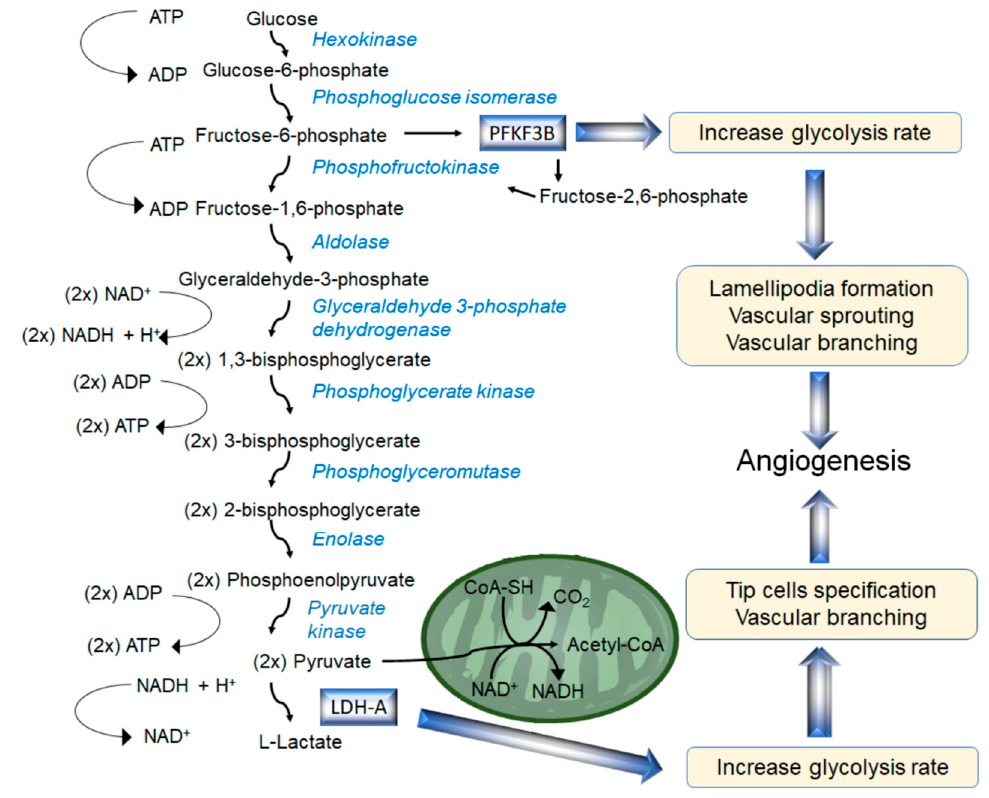
Figure 3. Enzymatic reactions of the glycolytic pathways: Glucose is converted to pyruvate in a series of enzymatic reactions. Pyruvate is then either transformed into L-Lactate by LDH-A (Lactate dehydrogenase) or translocated into the mitochondria and transformed into Acetyl-CoA before being integrated into the Tricarboxilic Acid (TCA) cycle. The enzymes PFKF3B (phosphofructo-2-kinase / fructose-2,6-biphosphatase) and LDH-A are part of a positive feedback loop and are upregulated by ECs to increase the glycolytic flux.